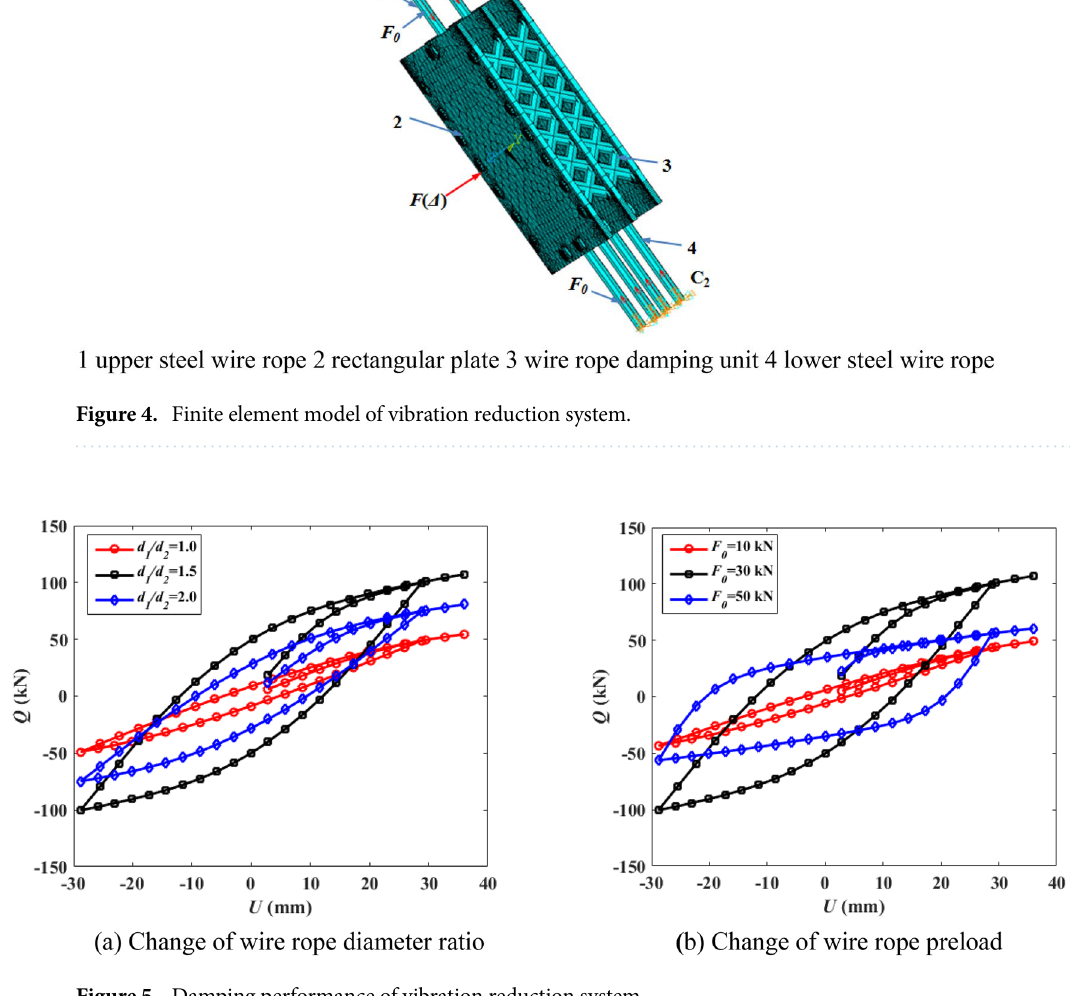
Figure 5. Damping performance of vibration reduction